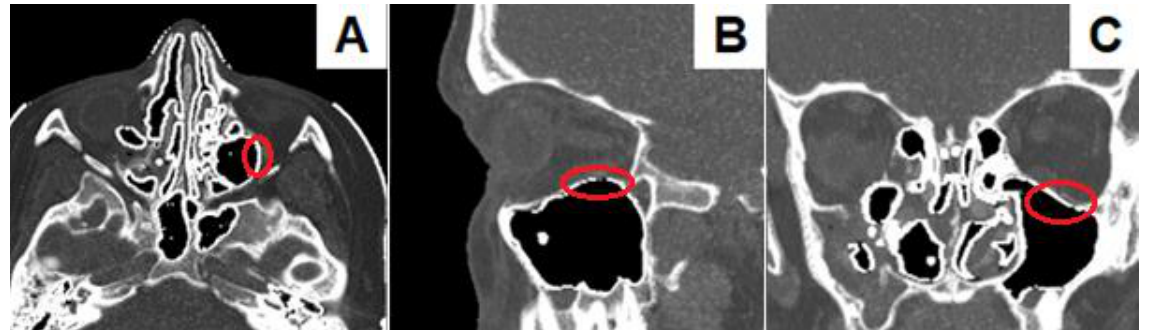
Figure 7. Three projections of the patient's head, constructed on the basis of the original DICOM images converted by modified special software: a – axial orientation; b – sagittal orientation; c – coronal orientation.